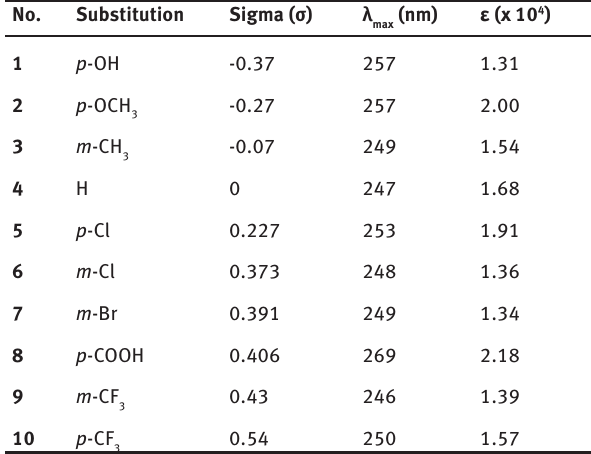
Table 1: Sigma values used for the determination of linear free energy (LFE) relationship in chlorination of substituted styrenes, experimentally determined wavelengths of maximal absorption and molar extinction